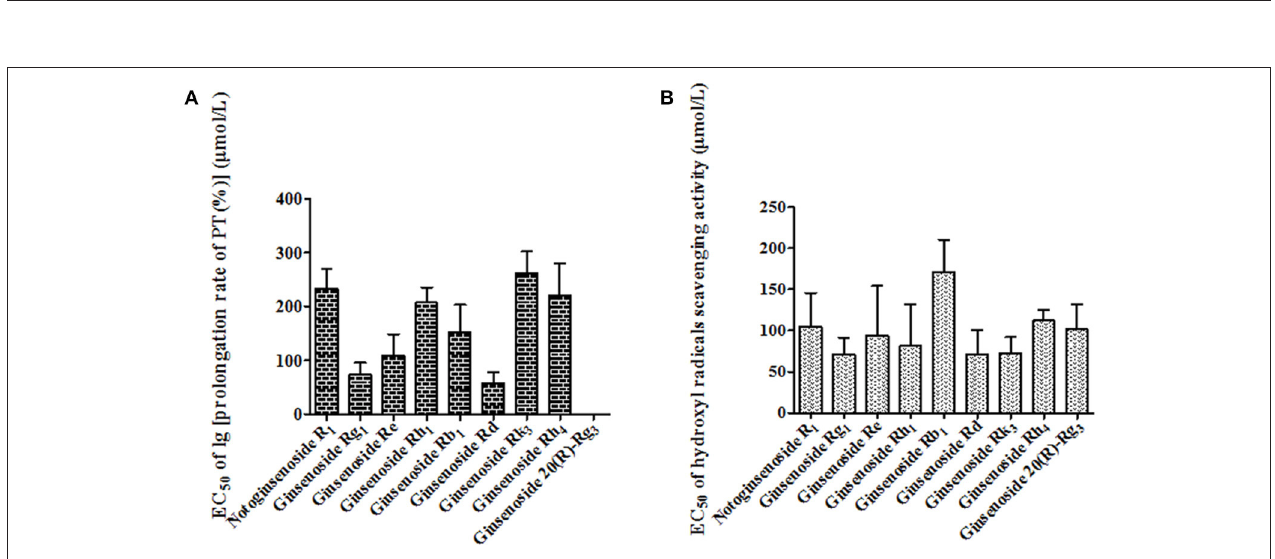
FIGURE 7 | The measured EC 50 values of anticoagulation (A) and antioxidation (B) of nine constituents in Panax notoginseng roots.